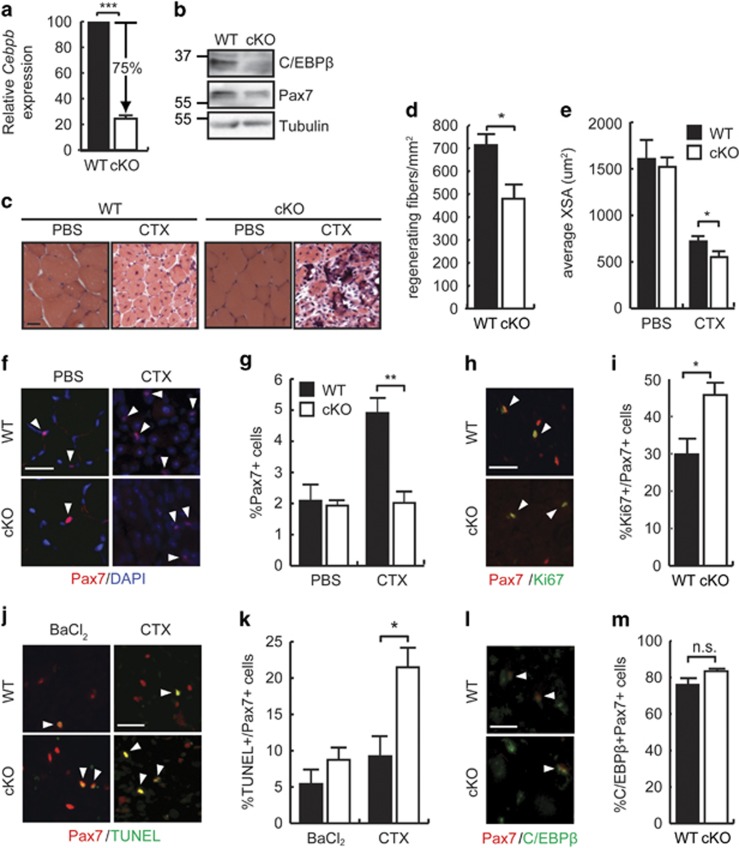
C/EBPβ protects muscle SCs from apoptosis following CTX injury. (a) Relative Cebpb mRNA expression in myoblasts isolated from WT (Cebpbfl/flPax7+/+) and cKO (Cebpbfl/flPax7CreERT/+) uninjured hind limb muscles, normalized to 18 S. Both groups received IP tamoxifen treatment to induce Cebpb excision in Cre-expressing animals. ***P=1 × 10−8, n=4. (b) C/EBPβ and Pax7 protein expression in primary myoblasts isolated from mice treated as in (a). Cyclophilin B (CyPB) is a loading control. (c) H&E-stained TA muscle cross-sections from female WT and cKO mice 7 days after injury with CTX or sham injured with PBS. Scale bar=20 μm. (d) Number of regenerating muscle fibers per mm2 in TA muscle from WT or cKO mice 7 days post-injury with CTX. *P<0.05, n=3. (e) Average fiber cross-sectional area (XSA) 7 days after injury with CTX or sham injury (PBS) in WT and cKO TA muscle. *P<0.05, n=4. (f) Pax7 immunostaining of WT and cKO TA muscle 7 days post sham (PBS) or CTX injury. Scale bar=20 μm. Arrowheads indicate positively stained cells. (g) Percentage of Pax7+ cells (relative to total DAPI+ nuclei) found in TA muscle from (f). **P=0.010, n=3. (h) Representative images of TUNEL and Pax7 immunostaining of TA muscle 4 days after injury with BaCl2. Scale bar=20 μm. (i) Percentage of Ki67/Pax7+ cells relative to total Pax7+ cells in the TA of WT and cKO mice from (h). *P<0.05, n=3 (j) Representative images of immunostaining for Pax7 and TUNEL staining on WT and cKO TA muscle 4 days after injury with BaCl2 or CTX. Scale bar=20 μm. (k) Percentage of TUNEL+/Pax7+ cells (relative to total Pax7+ cells) in TA of WT and cKO as in (j). *P<0.05, n=3. (l) Representative images of immunostaining for Pax7 and C/EBPβ on TA muscle from WT and cKO 7 days after injury with CTX. Scale bar=20 μm. (m) Percentage of C/EBPβ+/Pax7+ cells (relative to total Pax7+ cells) in TA muscle as in (l). NS, not significant